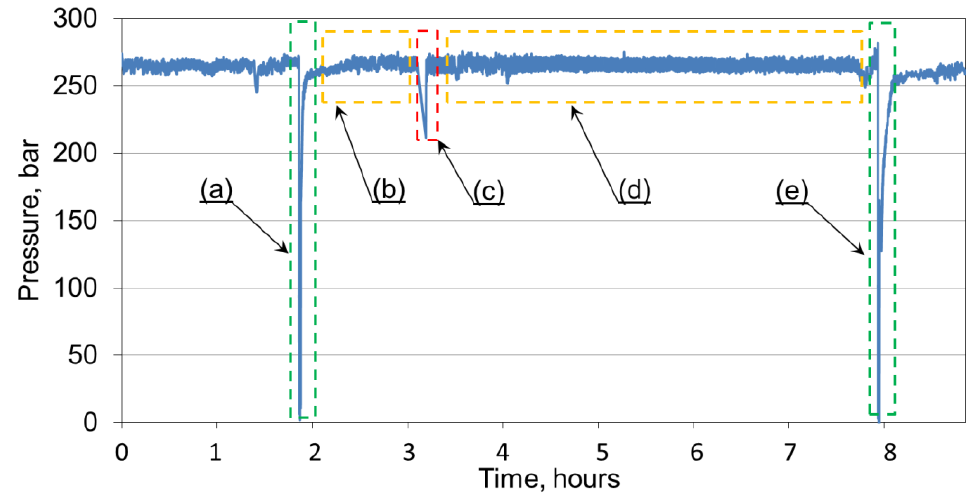
Figure 9. Analysis of the charging function during the tests.